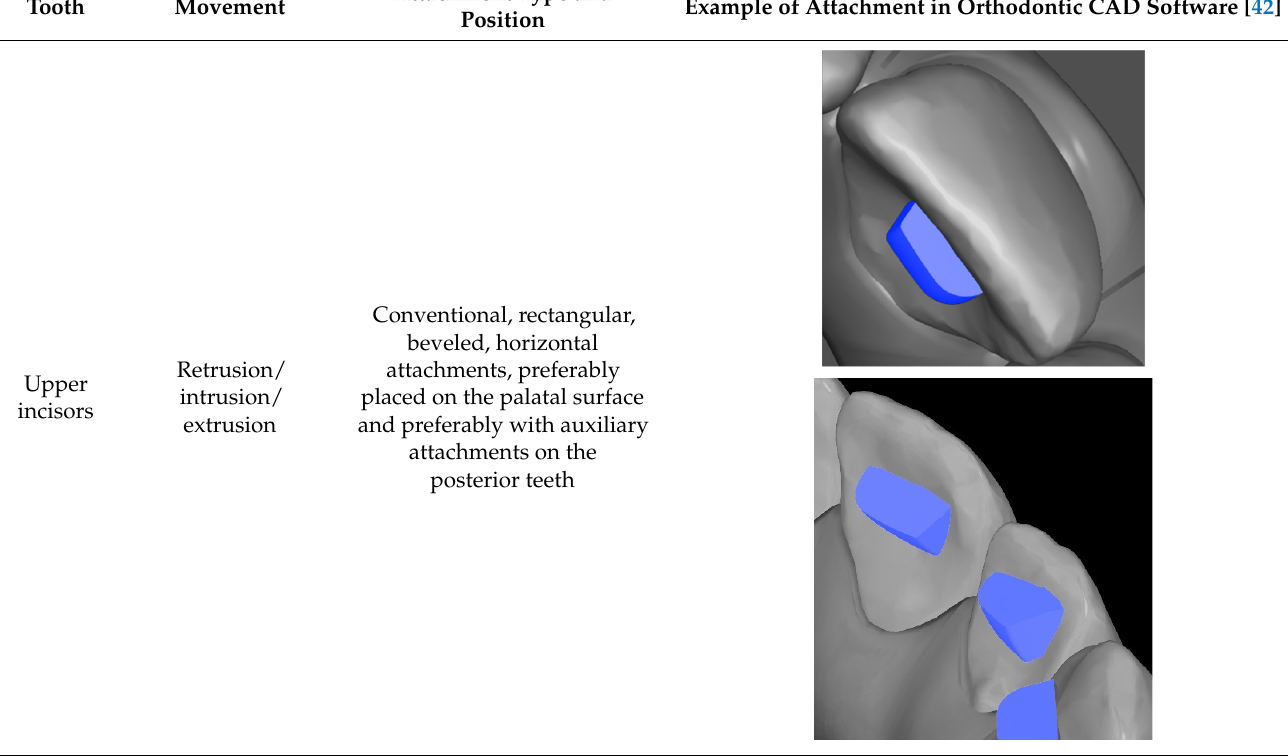
Table 7. Clinical guide for effective composite attachment placement basing on information in included studies.